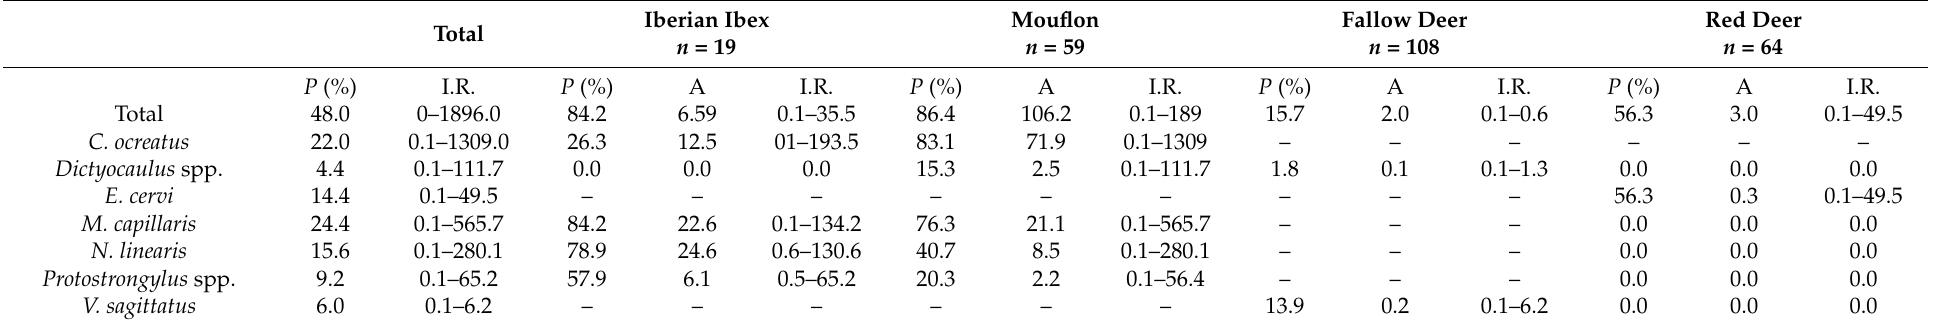
Table 1. List of nematode species and their prevalence, abundance and intensity. P: Prevalence (%); A: Mean abundance (larvae per lung gram); I.R.: Intensity Range (minimum and maximum larvae per lung gram values). Minus values (–) represent parasites not analyzed in the host species.